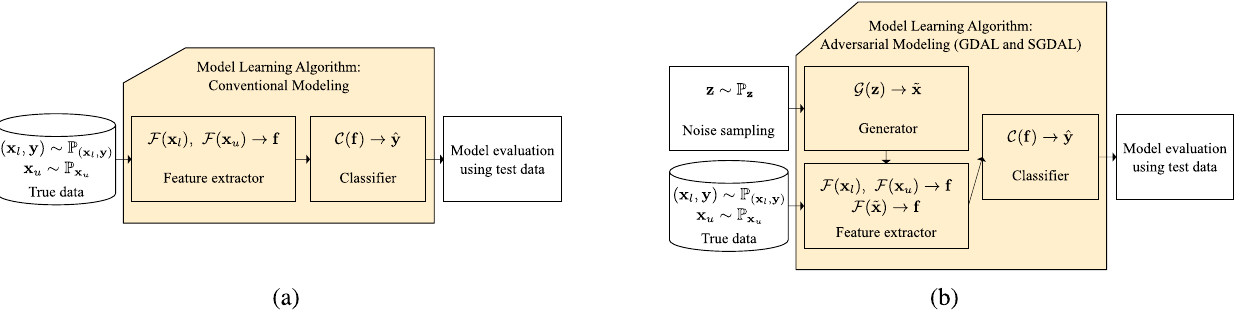
Figure 1. Comparison of learning schemes. ( a ) A conventional non-adversarial learning uses a training dataset (labeled and/or unlabeled) to learn the machine learning algorithm. On the other hand, ( b ) adversarial learning leverages artificially generated samples from random noise to learn the